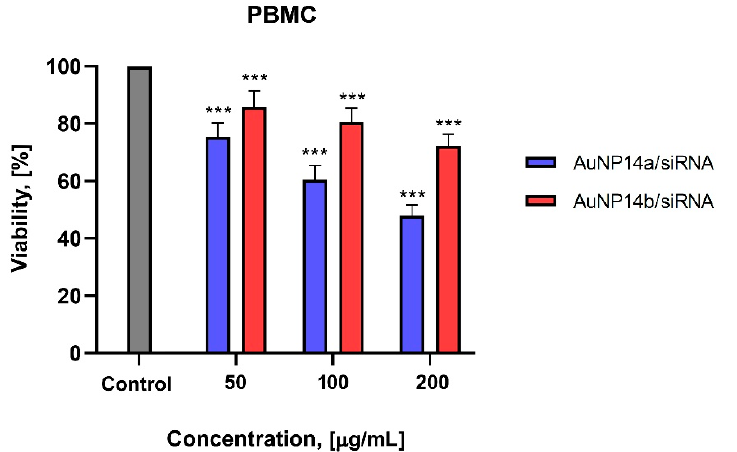
Figure 7. Viability of PBMC cells after incubating with AuNPs/siRNA complexes, Alamar Blue assay. Statistical effects showed in comparison to control cells. The concentration of siRNA is 1 µmol/L, incubation time 24 h. Data points represent means ± SD obtained from min. 3 separate experiments. Statistical significance was assessed using a two-way ANOVA test ( n = 3, *** p < 0.0001).